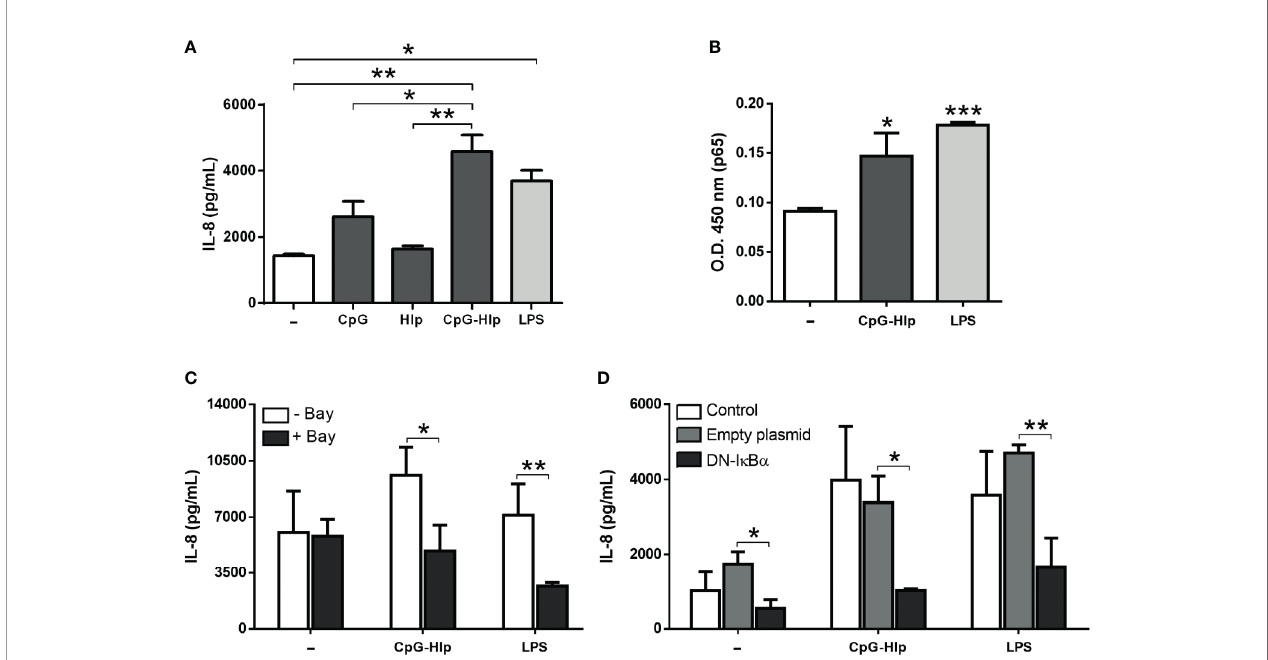
FIGURE 4 | Mycobacterial CpG-Hlp complex induces immune activation of human alveolar epithelial cells. Quanti fi cation of IL-8 levels in the culture supernatant (A, C, D) and assessment of the relative levels of p65 subunit in the nuclear extracts (B) of A549 cells through ELISA. (A) Cells were stimulated with CpG, rHlp, or CpG-Hlp complex for 48 hours. LPS was used as a positive control. (B) Cells were stimulated with CpG-Hlp complex or LPS for 30 minutes. (C, D) Cells were pretreated with Bay11-7082 (C) or transfected with DN-I k B a (D) and then stimulated with CpG-Hlp complex or LPS for 24 hours. (A) ANOVA test with differences considered statistically signi fi cant between them after applying Bonferroni post-test. (B – D) Unpaired t -test with differences considered statistically signi fi cant in relation to the untreated cells (B) or between them (C, D) . *p < 0.05; **p < 0.01; ***p < 0.001. Values represent the mean ± standard deviation of at least 3 independent experiments performed in